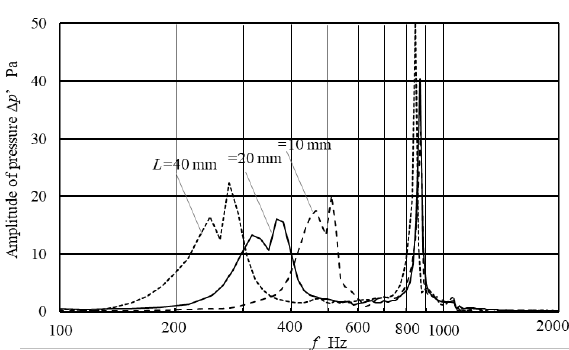
Figure 12. Spectrum of pressure amplitude for the nozzle lengths, L = 10.20, and 40